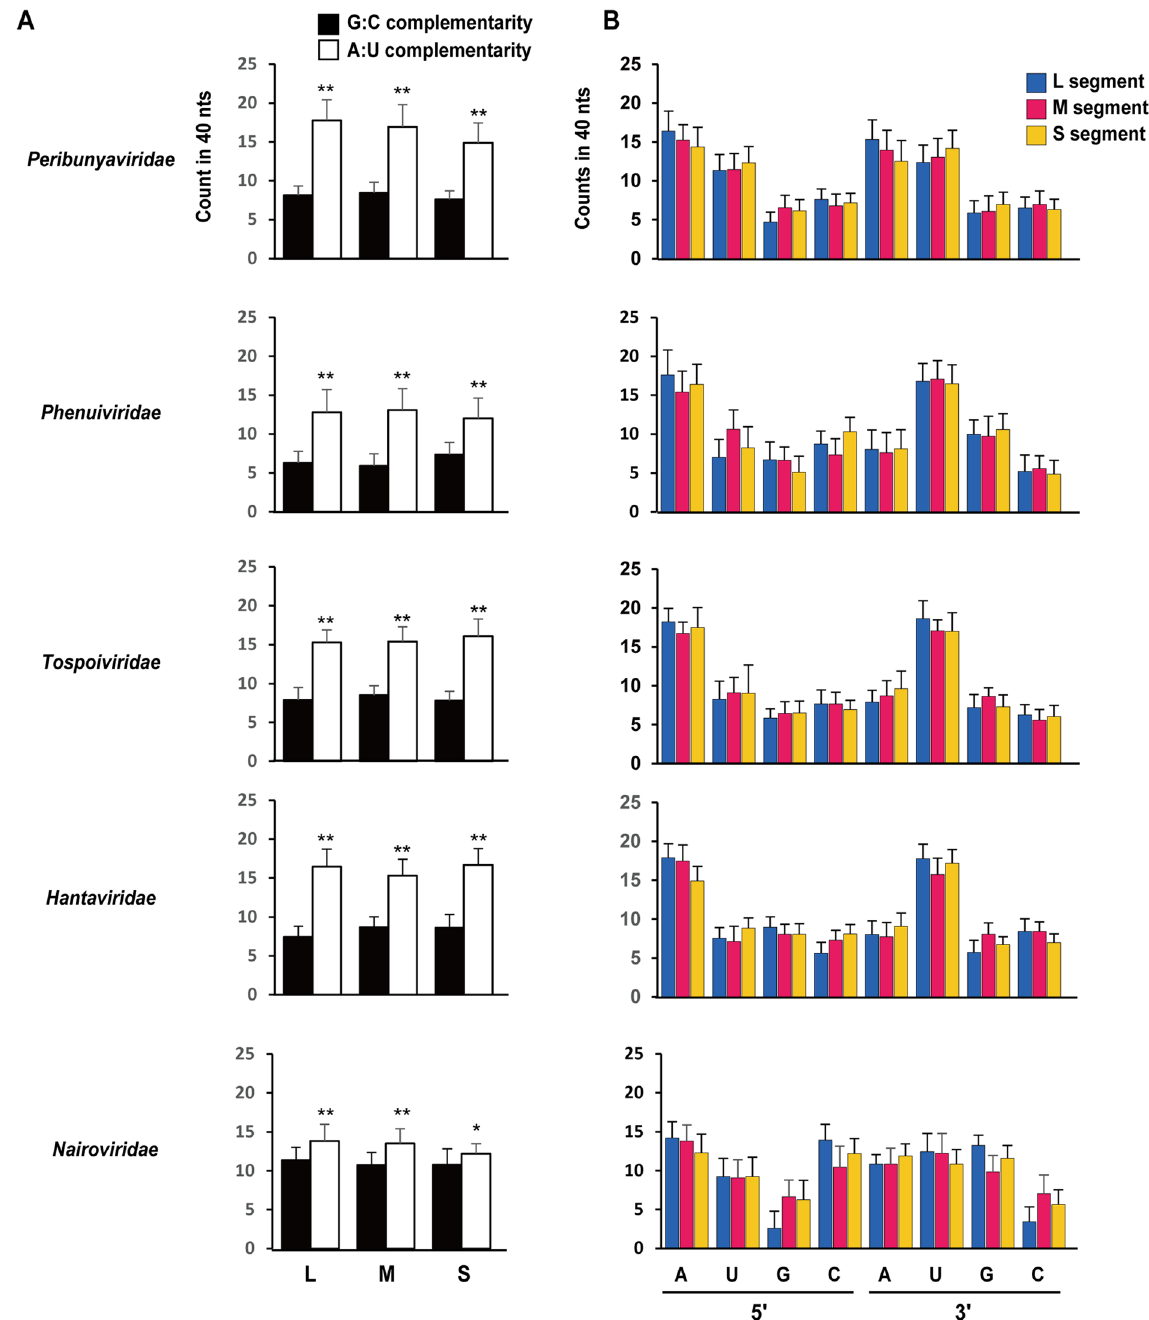
Figure 3. Counts of G:C and A:U complementarity, and each nt (A, U, G, and C) in the promoters. ( A and B ) The counts of G:C and A:U complementarity ( A ) and each nt ( B ) in the 40 nts of the promoters. Bars represent the means and standard deviations. Virus species in the following families were examined: Peribunyaviridae (n = 56), Phenuiviridae (n = 47), Tospoviridae (n = 19), Hantaviridae (n = 24), and Nairoviridae (n = 20). ** p < 0.01, * p < 0.05, two-tailed unpaired Student’s t -test (G:C vs. roviruses, in the L, M and S segments. The lengths of these sequences are shown in Fig. 5A. The family Nairoviri- dae contains two highly pathogenic viruses in mammals, i.e., CCHFV and Nairobi sheep disease virus (NSDV), which have a mortality rate of 30% and 90% in humans and small ruminants, respectively 12,13 . The length of the sequences of CCHFV and NSDV are shown as red and yellow bars, respectively, in Fig. 5A. The lengths of the M segments of CCHFV and NSDV were found to be the longest among virus genome sequences possessing 5 ′ -UCUC—GAGA-3 ′ ends.